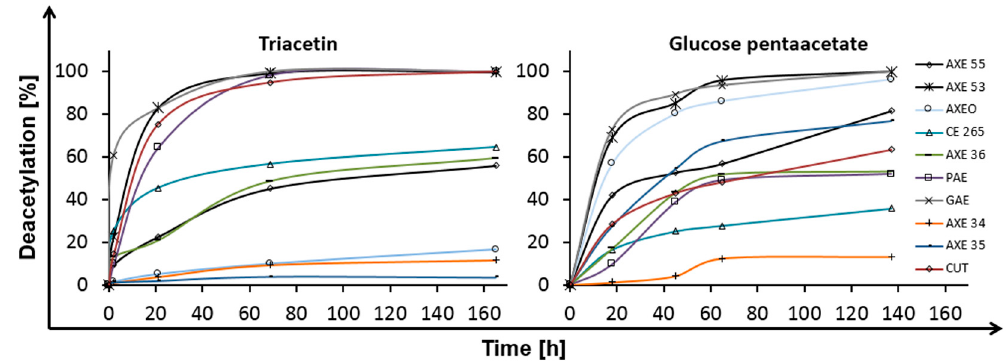
Figure 2. Deacetylation of glucose pentaacetate and triacetin by different esterases. Triacetin is a plasticizer in cigarette filters and glucose pentaacetate serves as small model compound for CA. Axetyl xylan estarase (AXE); carbohydrate esterase (CE); cutinase (CUT); glucomannan acetyl esterase (GAE); and pectin acetyl esterase (PAE).